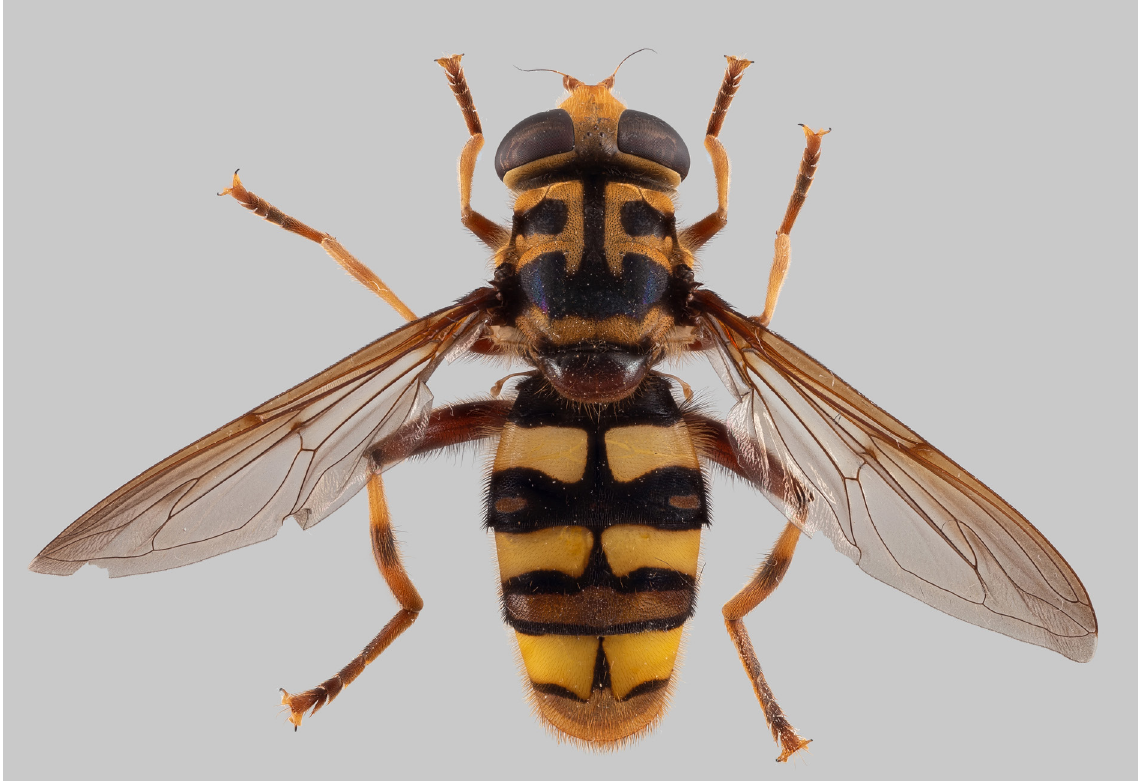
Fig. 3. Milesia cretica Bot & van Steenis sp. nov., paratype, ♀ (SBH), habitus dorsal. Collected on Crete, near Lakkoi, 9 October 2021, leg. and coll. S.